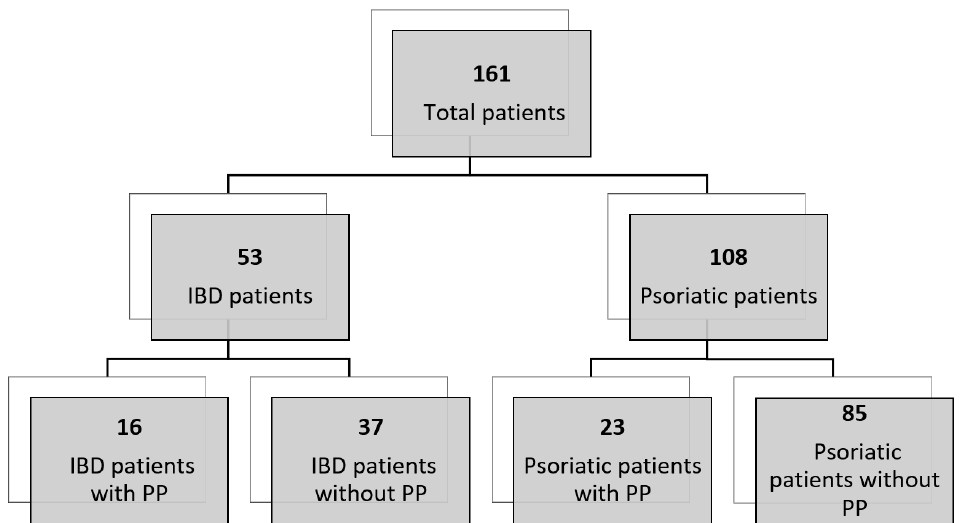
Figure 1. Diagram showing the number of patients analyzed in the present